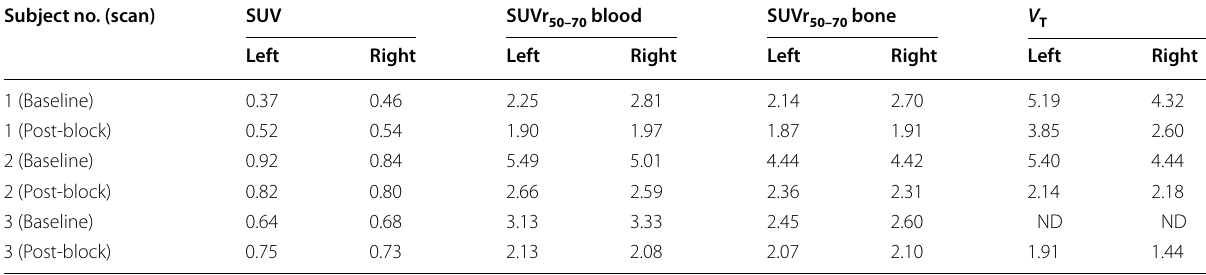
Table 2 Uptake parameters for all the subjects